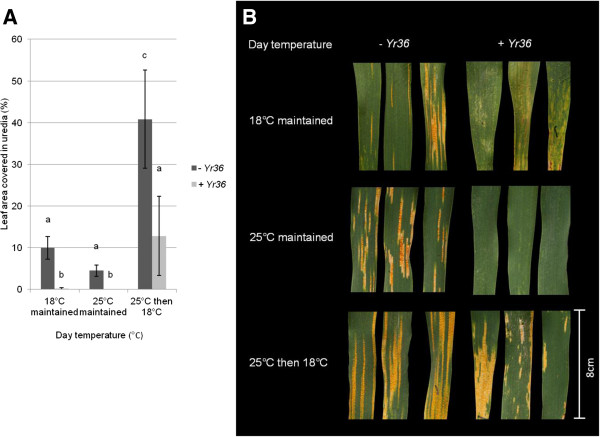
The effect of changes in temperature on yellow rust resistance in adult plants of wheat lines UC1041 +/- Yr36. A) Mean percentage (%) leaf area covered in pustules at 18 dpi on UC1041 - Yr36 (dark grey) and UC1041 + Yr36 (light grey) adult plants inoculated with Pst isolate 08/21 under three different temperature treatments. Mean values (± 1 standard error) were obtained from six biological replicates. Data was analysed using the general linear model and statistically significant differences are indicated by a different letter (P <0.01). B)Pst symptoms at 18 dpi on flag leaf sections from plants at the three temperature treatments. Uredia can be observed within necrotic/chlorotic areas on the leaf surface.